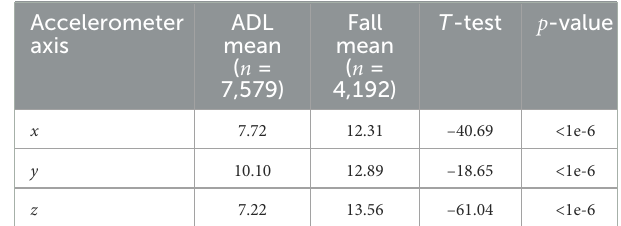
TABLE 2 t -test of the means of maximum acceleration values for ADLs and falls, split by axis. Accelerometer